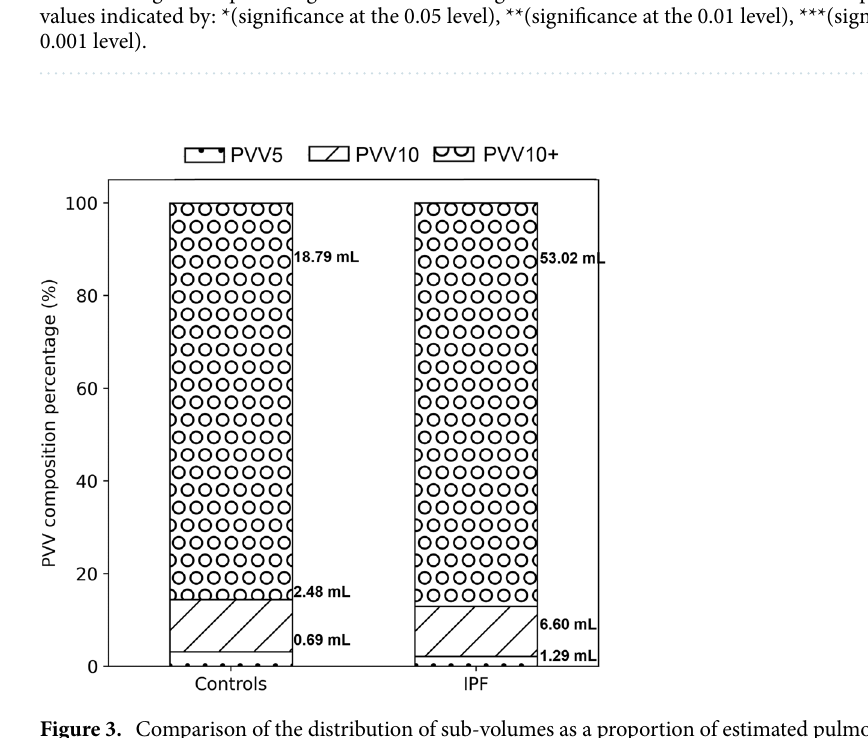
Figure 3. Comparison of the distribution of sub-volumes as a proportion of estimated pulmonary vessel-like volume (PVV) for IPF and controls. The stacked bars indicate the percentage of PVV that is PVV10 + (dotted hatch), PVV10 (slashed hatch), and PVV5 (grey hatch). Numerical labels indicate the absolute volumes (mL) of each volume compartment. PVV5: volume of vessels with cross-sectional area less than 5 mm 2 ; PVV10: volume of vessels with cross-sectional area 5–10 mm 2 ; PVV10 + : volume of vessels with cross-sectional area > 10 mm 2 .